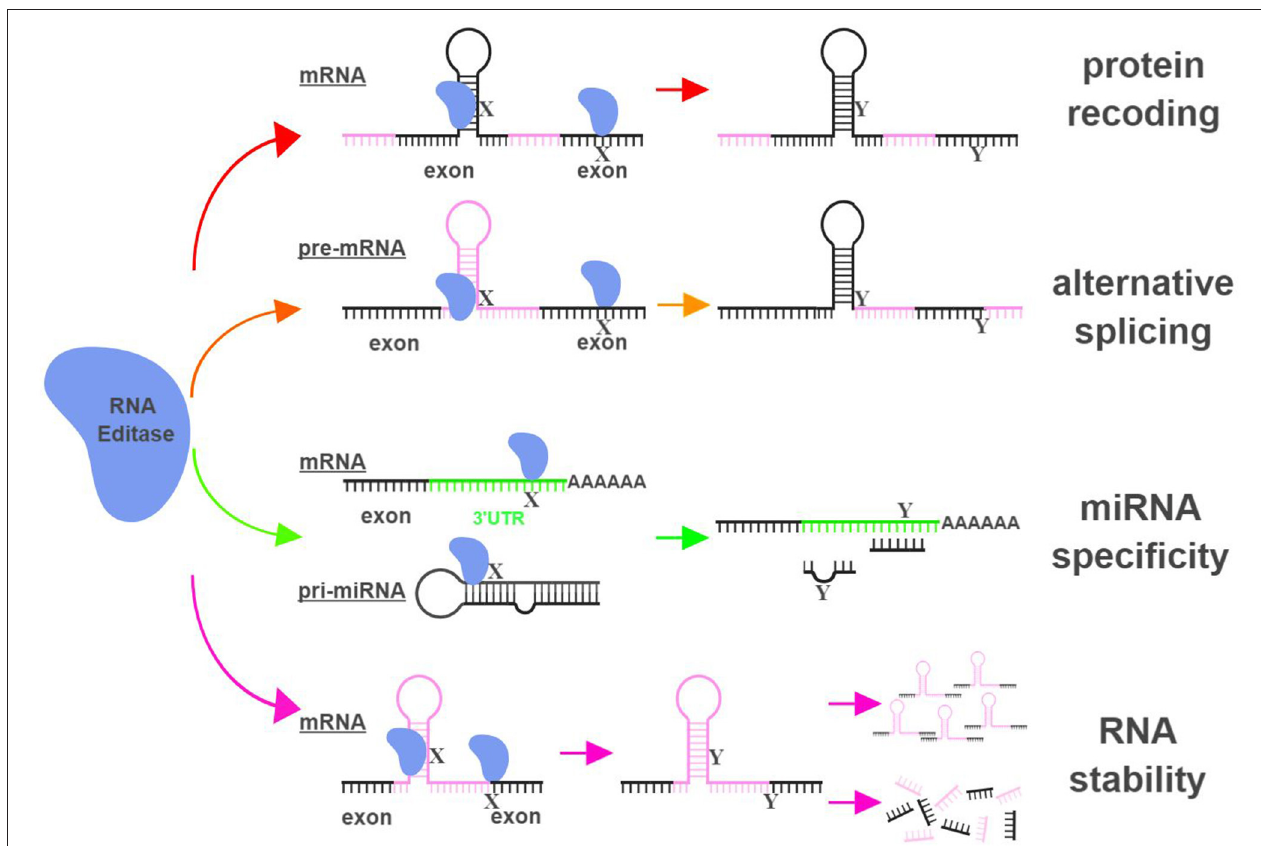
FIGURE 1 | RNA editing leads to functional consequences through multiple mechanisms. RNA editases (ADAR1, ADAR2, ADAR3, and APOBECs in this review) regulate their targets through multiple mechanisms, including altering mRNA sequences in exons to change amino acid sequences (protein recoding; red arrows), changing splicing patterns of pre-mRNA to create novel products (alternative splicing; orange arrows), influencing miRNA specificity by altering seed sequences of miRNAs or sequences of miRNA targeting sites (miRNA specificity; green arrows), and directly impacting the stability of edited RNAs (RNA stability; magenta arrows). X represents a RNA base targeted by RNA editases (A denosine for ADARs; Cytidine or Guanosine for APOBECs), and Y represents the resultant RNA base after the editing (Inosine for ADARs; Uridine or Adenosine for APOBECs). The hairpin structure in the mRNA represents Alu repeat elements that are frequently targeted by RNA editases. UTR, untranslated region. The figure was created with